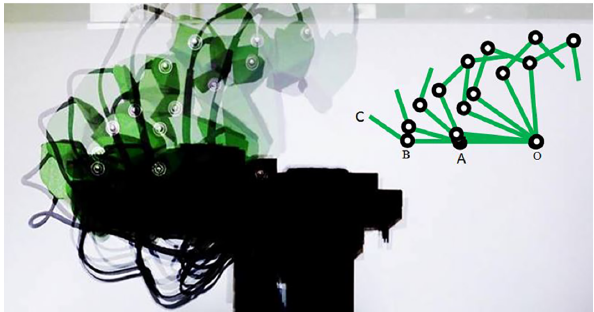
Figure 11. Workspace of the designed CPRF for seven situations with 10 ◦ step between each